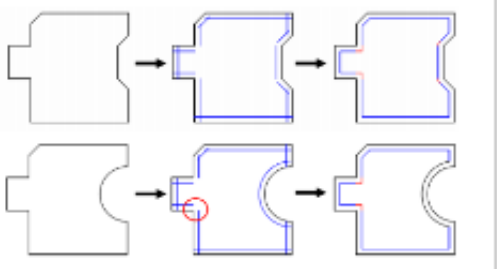
Figure 10. Rule 2 - converts a mass model into a higher level of detail (LoD) model.